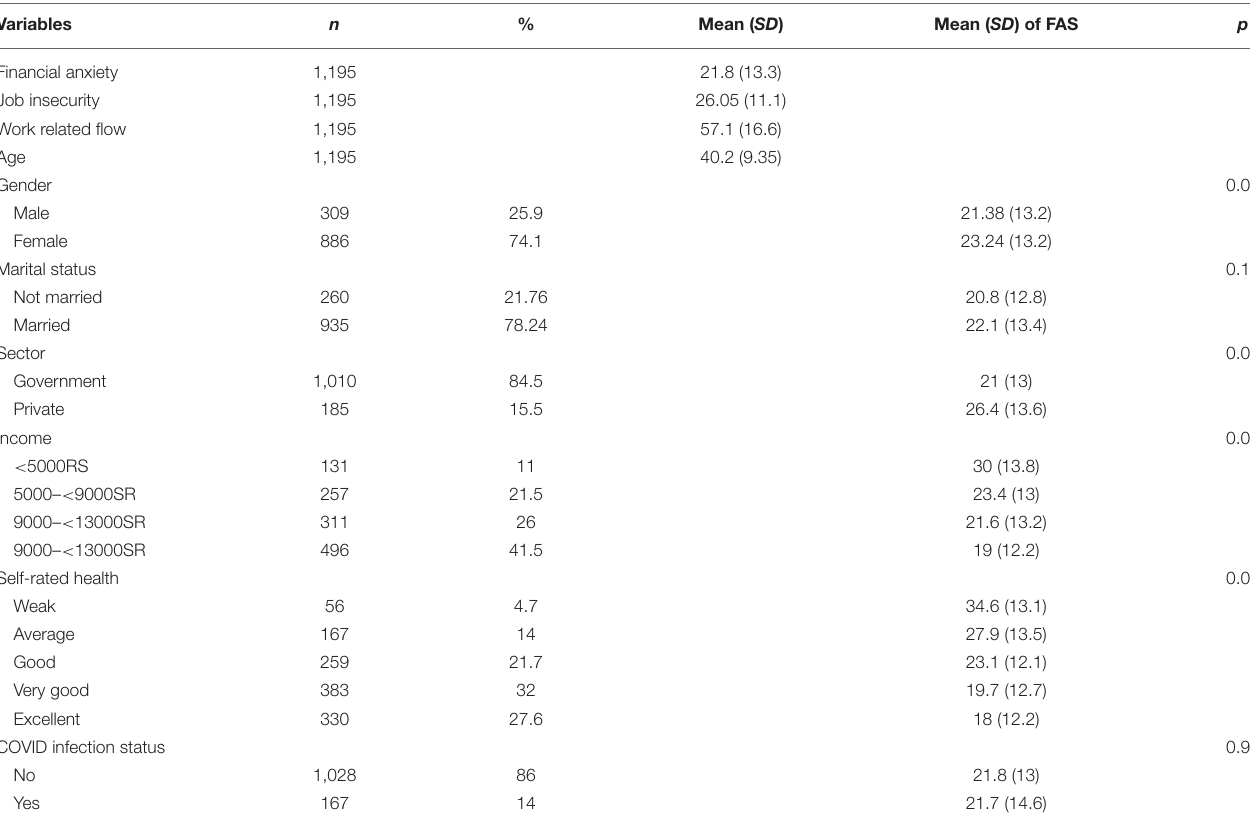
TABLE 2 | Socio-demographic characteristics of the sample and mean of FAS per category.